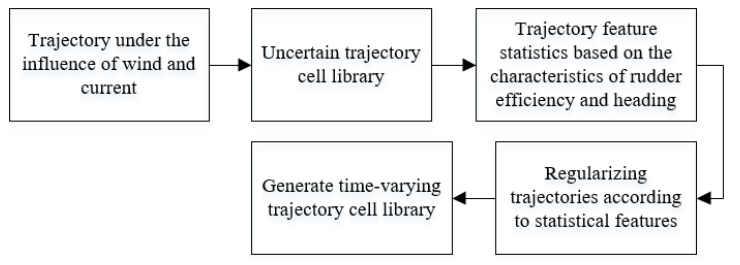
Figure 5. Construction process of a regularization-trajectory cell.